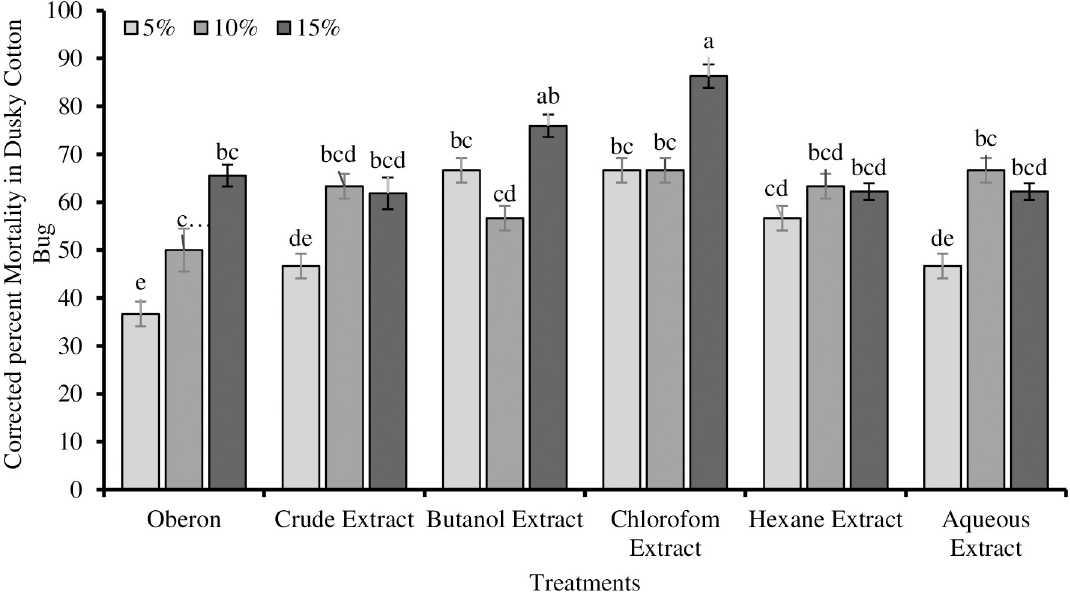
Fig 6. Corrected % mortality in Oxycarenus hyalinipennis (dusky cotton bug) after exposure to different solvent-based extracts of Euphorbia nivulia Buch.-Ham. and an insecticide Oberon, at different